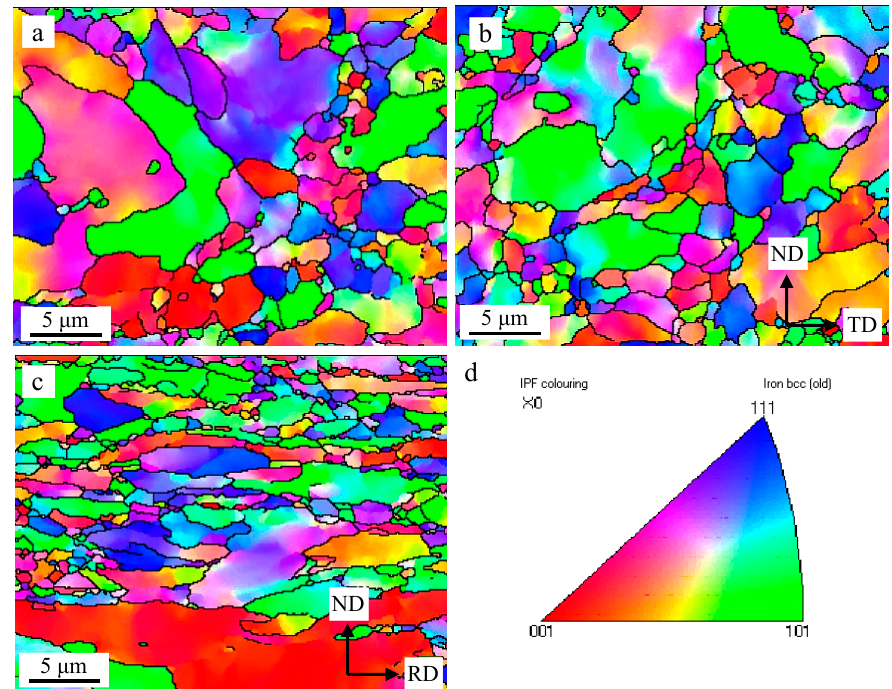
Figure 1. EBSD analyses of the 15Cr-Al-Zr-ODS alloys before and after TMP (thermomechanical processing): ( a ) HIP (hot isostatic pressing); ( b ) ND (normal direction)-TD (transverse direction) section, HIP+TMP; ( c ) ND-RD (rolling direction) section, HIP+TMP; ( d ) inverse pole figure (IPF) contour map